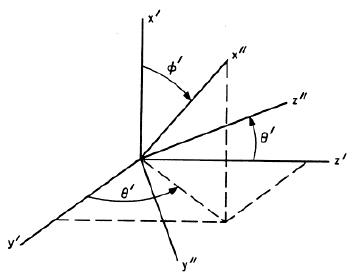
Figure 7. Relationship of x (cid:48) , y (cid:48) , z (cid:48) and x (cid:48)(cid:48) , y (cid:48)(cid:48) , z (cid:48)(cid:48) axes. Figure 7. Relationship of x’, y’, z’ and x”, y”, z” axes.